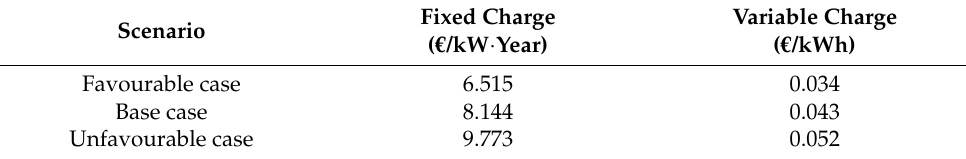
Table 3. Self-consumption charges. Source: